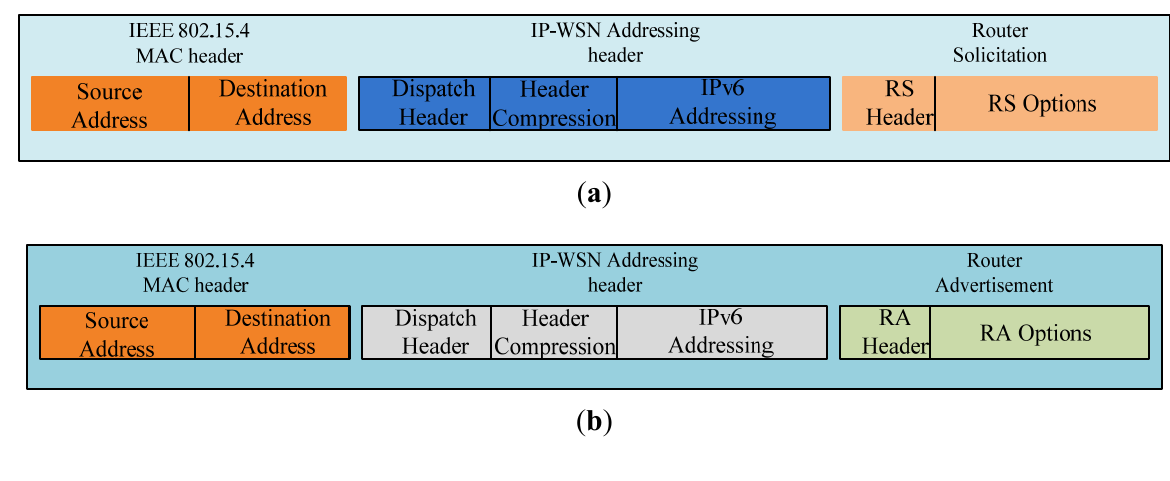
Figure 12. ( a ) IP-WSN Router Solicitation (RS) Message Format; ( b ) IP-WSN Router Advertisement (RA) Message